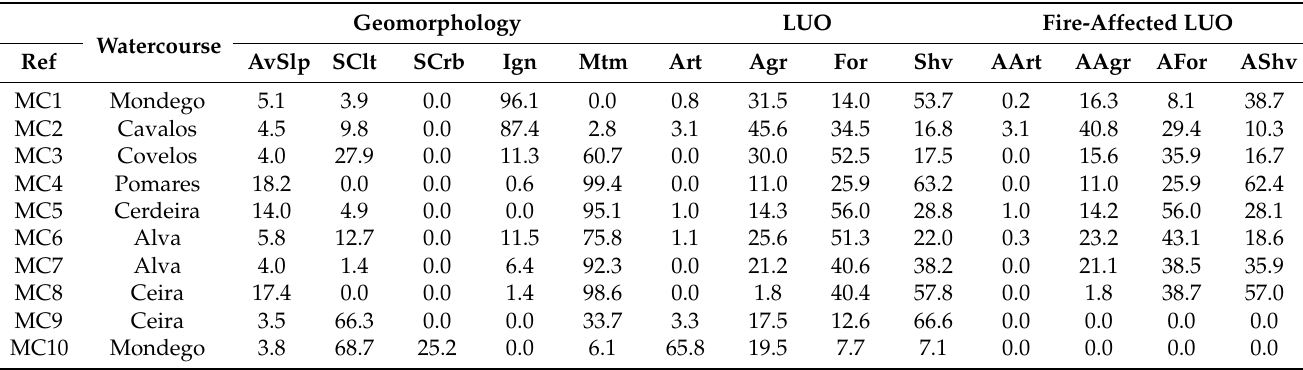
Figure 2. Study area and the location of the monitored catchments. In the region are cropped out Paleozoic granitoids, mainly in its northern and east- ern sectors; Precambrian-Paleozoic meta-sedimentary units, mainly to the south; and sedimentary units in small continental basins and river valleys [31]. To the west lies a Meso-Cenozoic sedimentary succession with siliciclastic and carbonate units (Table 1). The monitored catchments (MC) also have high variable morphologies, as the southernmost present higher slopes contrasting to flatter catchments to the north and particularly to the east (Table 1). Table 1. Monitored catchments areas, their average slope (AvSlp), area of clastic sedimentary (SClt), carbonate sedimentary (SCrb), igneous (Ign), metamorphic (Mtm) geology, area of artificial (Art), agricultural (Agr), forest (For), shrub and/or herbaceous vegetation (Shv) LUO and fire-affected counterparts (A). The AvSlp is in degrees and all areas are in percentage of the